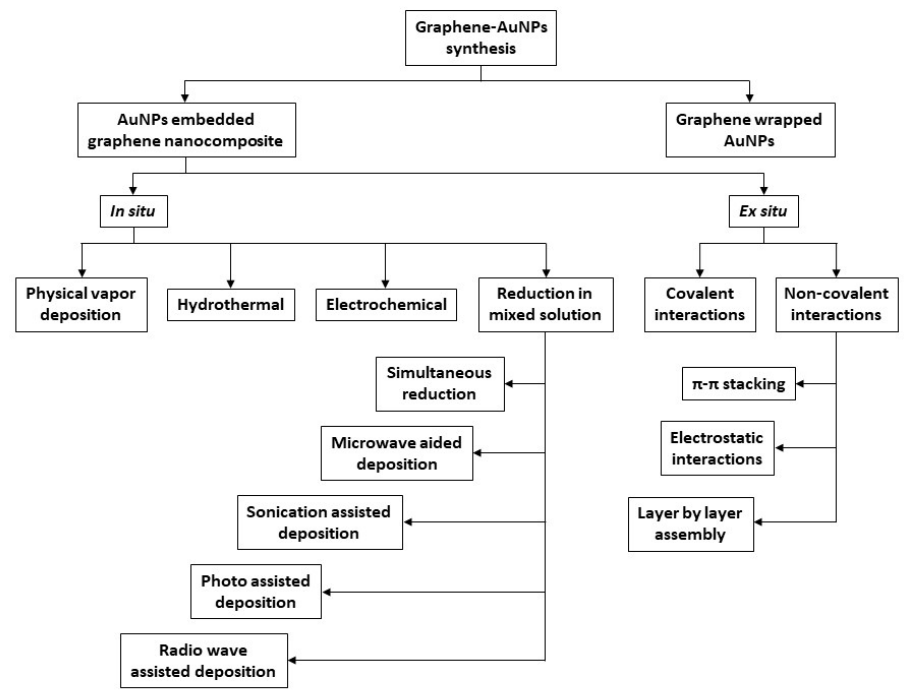
Figure 5. Schematic representation of the synthetic pathways of graphene-AuNPs nanocomposites.